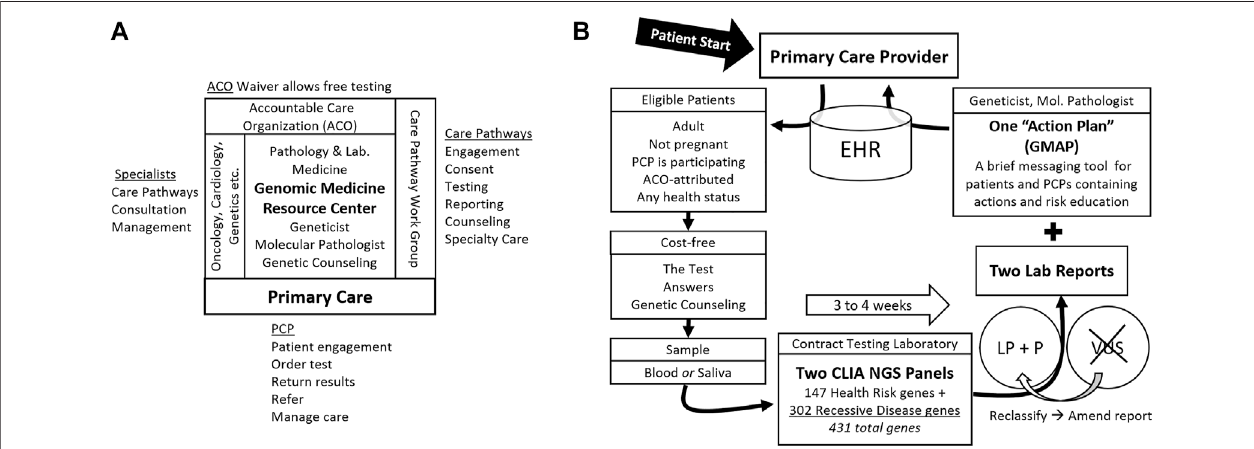
FIGURE 1 | Genomic Population Health Pilot Program: Organization and Testing Process. (A) The multi-disciplinary team, its interfaces, and team member activities. The Genomic Medicine Resource Center provides support for primary care providers (PCP) and patients and coordinates the team. (B) The testing process and test details. Patients engage fi rst with their primary care provider (PCP). Arrows indicate steps in the process. Abbreviations: Electronic health record (EHR), accountablecareorganization(ACO),ClinicalLaboratoryImprovementAmendments(CLIA),nextgenerationsequencing(NGS),likelypathogenic(LP),pathogenic (P), variant of uncertain signi fi cance (VUS), and Genomic Medicine Action Plan